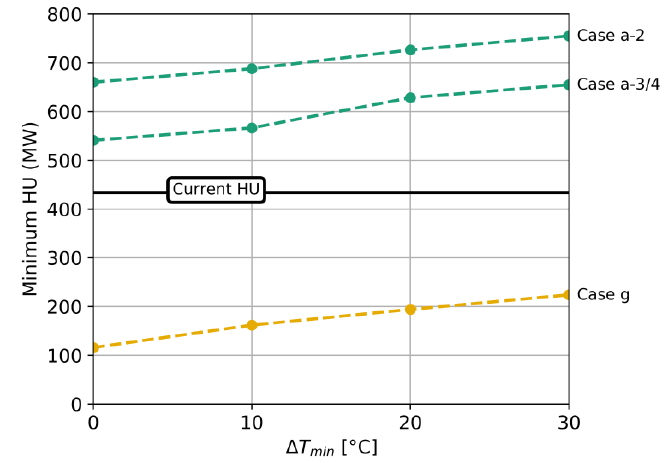
Figure 8. Hot utility targets for cases without direct heat recovery (cases a-2 to a-4) and with unrestricted heat recovery across the complete site (case g).